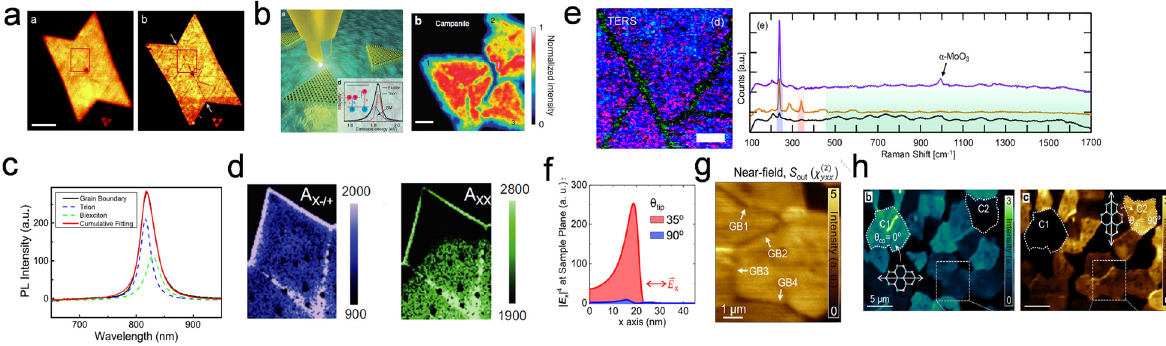
Figure 2: Near-field images of 1L-TMDs. (a) Confocal (left panel) and near-field (right panel) PL images of 1L-MoS 2 . Reproduced with permission from ref. [26]. Copyright 2015, Royal SocietyofChemistry.(b)Illustration(leftpanel)andnear- fi eldPLimage(rightpanel)of1L-MoS 2 usingtheCampaniletip.Inset:representative deconvoluted averaged spectra obtained by near- fi eld image. Reproduced with permission from ref. [55]. Copyright 2015, Nature Publishing Group. (c) Representative deconvoluted averaged PL spectrum of 1L-MoSe 2 . (d) Near- fi eld PL images of trion (left panel) and biexciton (right panel). Reproduced with permission from ref. [60]. Copyright 2020, Nature Publishing Group. (e) TERS image (left panel) and averaged TERS spectra(rightpanel).Reproducedwithpermissionfromref.[63].Copyright2018,AmericanChemicalSociety.(f)Simulatedoptical fi eldpro fi le at sample plane fortilted ( θ tip = 35 ° ) and( θ tip = 90 ° ) tip orientations. (g)Near-fieldsecond harmonicgeneration(SHG) image.(h) Far- fi eld SHG images measured parallel and perpendicular to the excitation direction con fi guration. Reproduced with permission from ref. [69]. Copyright 2018, American Chemical